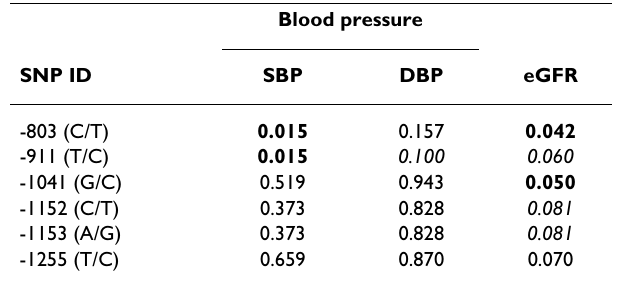
Table 4: P-values from association tests of NAT8 upstream SNPs: linear regression (additive model) adjusted for age, gender and